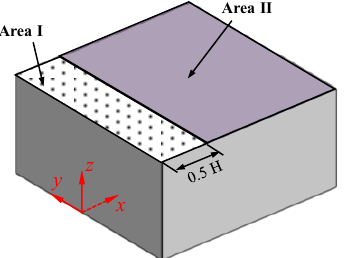
Figure 13. Schematic diagram of roof partition.